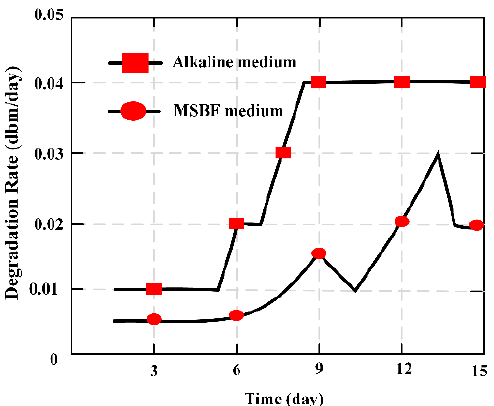
Figure 8. Degradation ratio of the MES (magnetoelastic sensors)-embedded MBAB (magnesium-based artificial bone) EMBAB (MES-embedded MBAB,) at increased time points in alkaline and MSBF (modified simulated body fluid) media over 15 days.